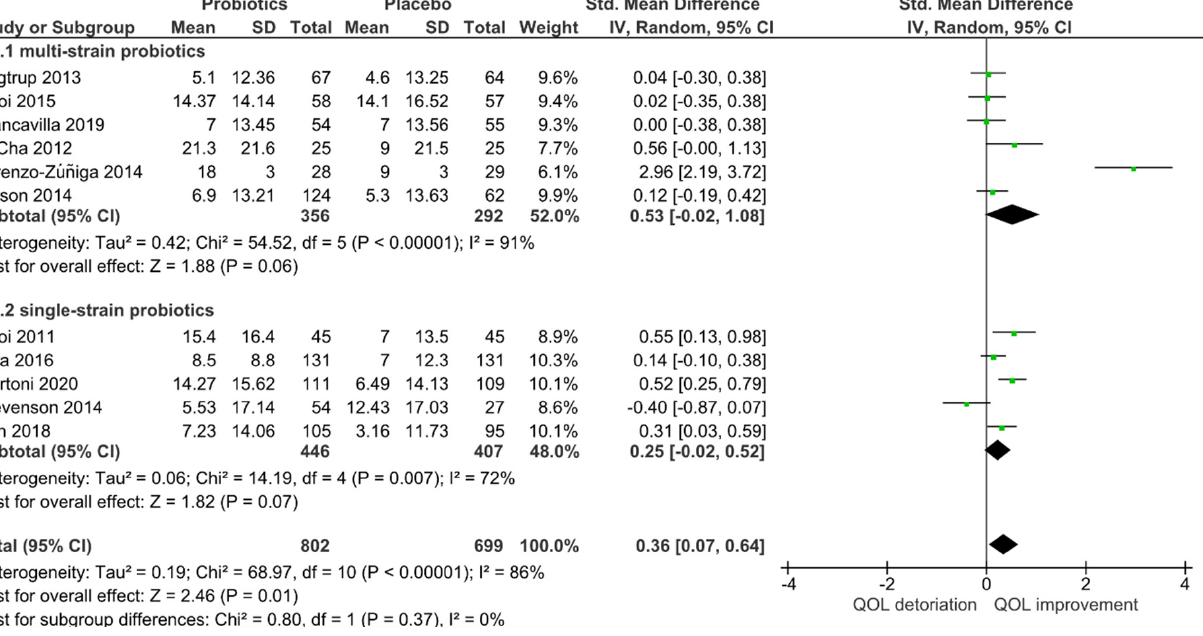
Figure 4. Effect of single-strain versus multi-strain probiotics on the quality of life (QoL) in randomized controlled trials for IBS receiving either probiotics or placebo treatment.